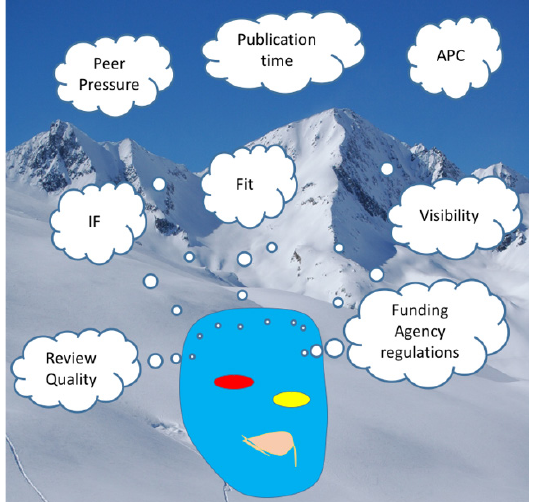
Figure 1. Some of the key factors influencing author choice of publication venue in the modern publishing environment. APC = Article Processing Charge; IF = Impact Factor. See also Table